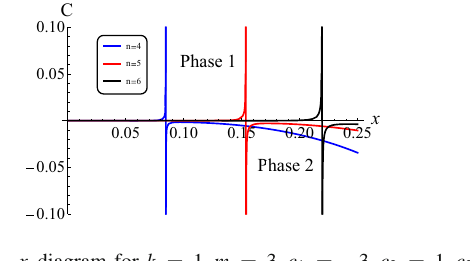
Fig. 5 C − x diagram for k = 1 , m = 3 , c 1 = − 3 , c 2 = 1 , c 3 =